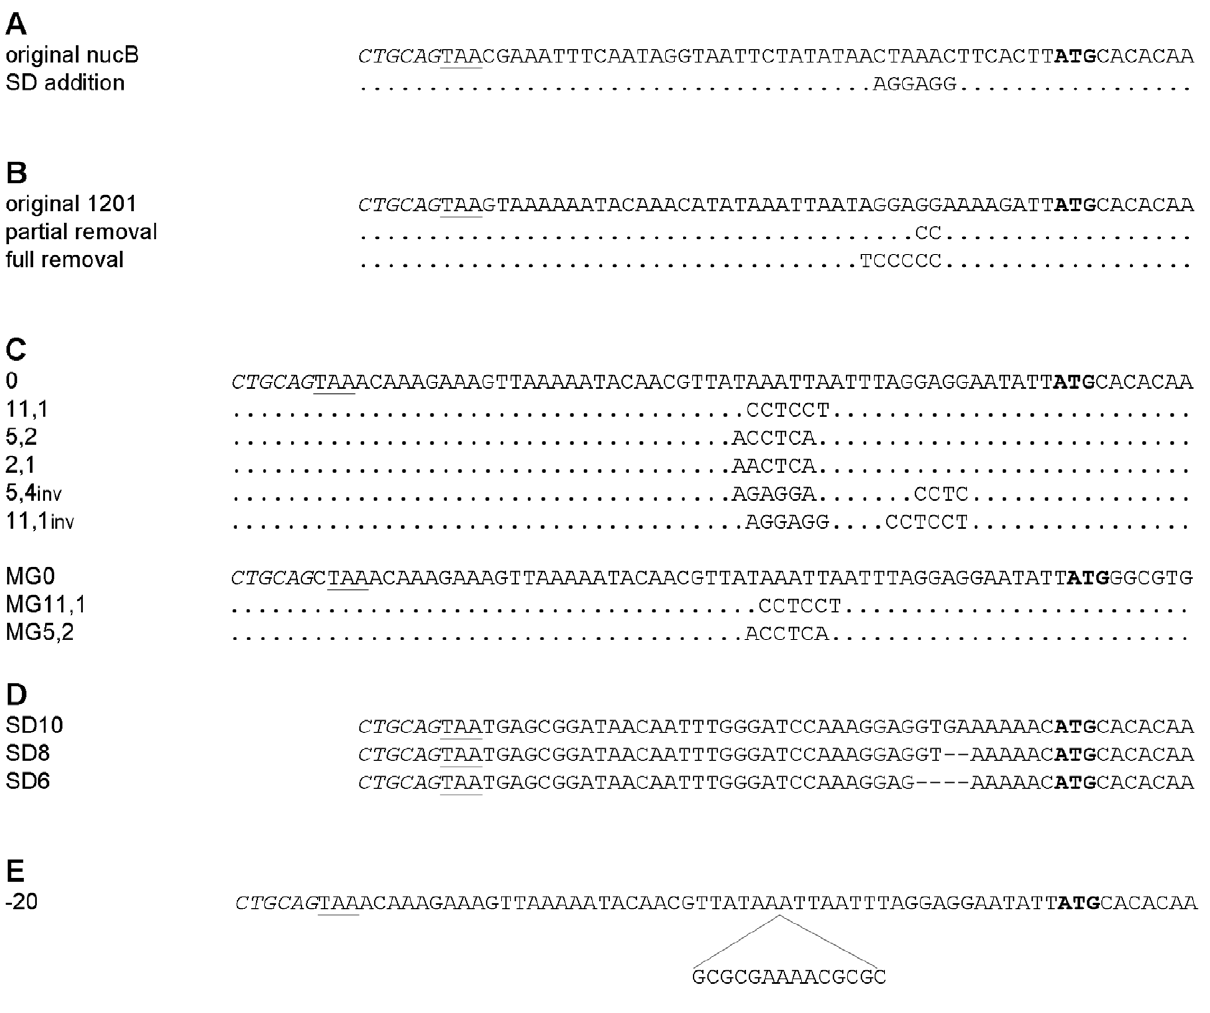
Figure 2. Start codon upstream sequences of plasmid borne reporter genes. The sequence starts with the Pst I site of the pRH3 or pUC19 vector (shown in italics). The stop codon at the start of the upstream sequence is underlined and the start codon of nucB or hMGFP is in boldface. A and B: nucB constructs with added (A) or removed (B) SD sequences. C: start codon upstream sequences containing SD sequences that are involved in formation of mRNA secondary structures with different stability. The sequences starting with mg were used in E. coli to translate the MGFP. D: Start codon upstream sequences of plasmid pRH3 borne nucB constructs containing SD sequence length of 10, 8, and 6 nucleotides. E: nucB upstream sequence used to asses the effect of secondary structure 20 bp upstream of the start codon. The secondary structure element was inserted into construct 0 from C after the designated adenosine.